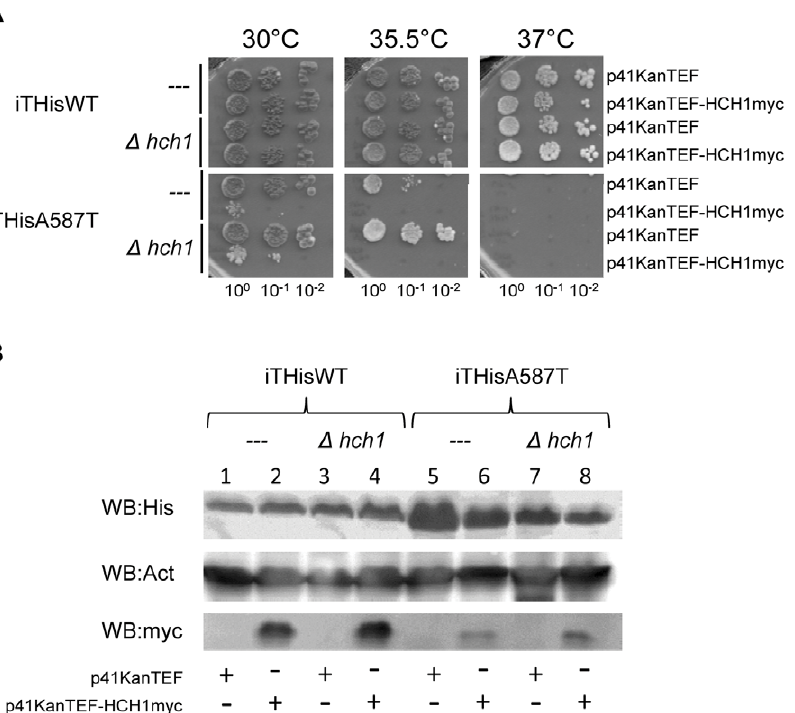
Figure 3. Overexpression of C-terminally myc-tagged Hch1p impairs growth of yeast expressing Hsp82p A587T but not yeast expressing wildtype Hsp82p. A. Cells were grown overnight in YPD supplemented with 200 mg/L G418 and then diluted to 1 6 10 8 cells per mL. 10-fold serial dilutions were prepared and 5 m L aliquots were spotted on YPD agar plates supplemented with 200 mg/L G418 and grown for 2 days at 30, 35.5 and 37 u C. B. Western analysis of yeast shown in 3A with anti-myc tag, anti-His tag and anti-actin antibodies. Levels of mycHch1p (lanes 2, 4, 6, and 8) in strains expressing Hsp82p (lanes 1–4), or Hsp82p A587T (lanes 5–8) with (lanes 3,4, 7, 8) or without (lanes 1, 2, 5, 6) HCH1 deletion. (Anti-myc antibody